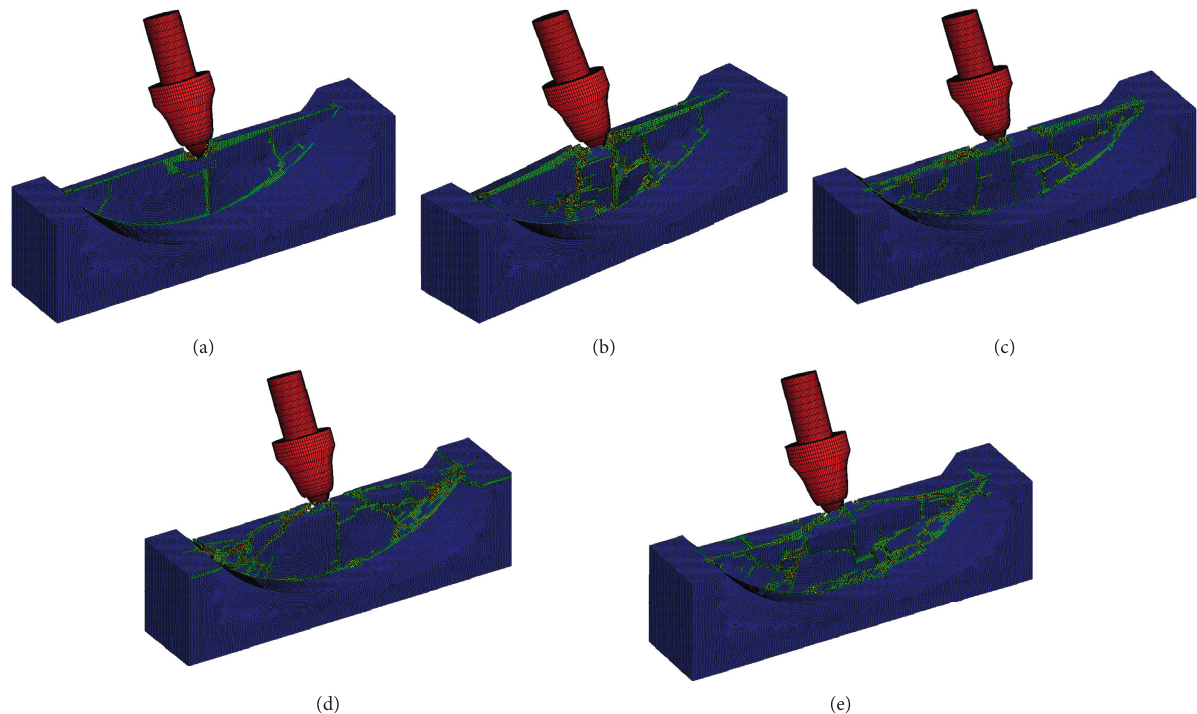
Figure 9: Numerical simulation results of conical pick cutting arc rock plate with various